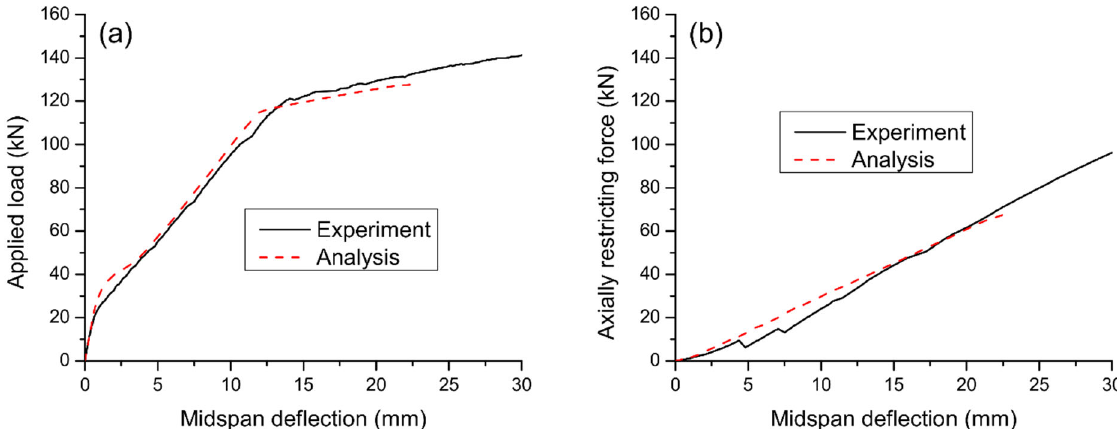
Figure 4. Comparison between numerical predictions and experimental data for B6. ( a ) load ‐ deflec ‐ tion curve; ( b ) axially restricting force versus deflection.